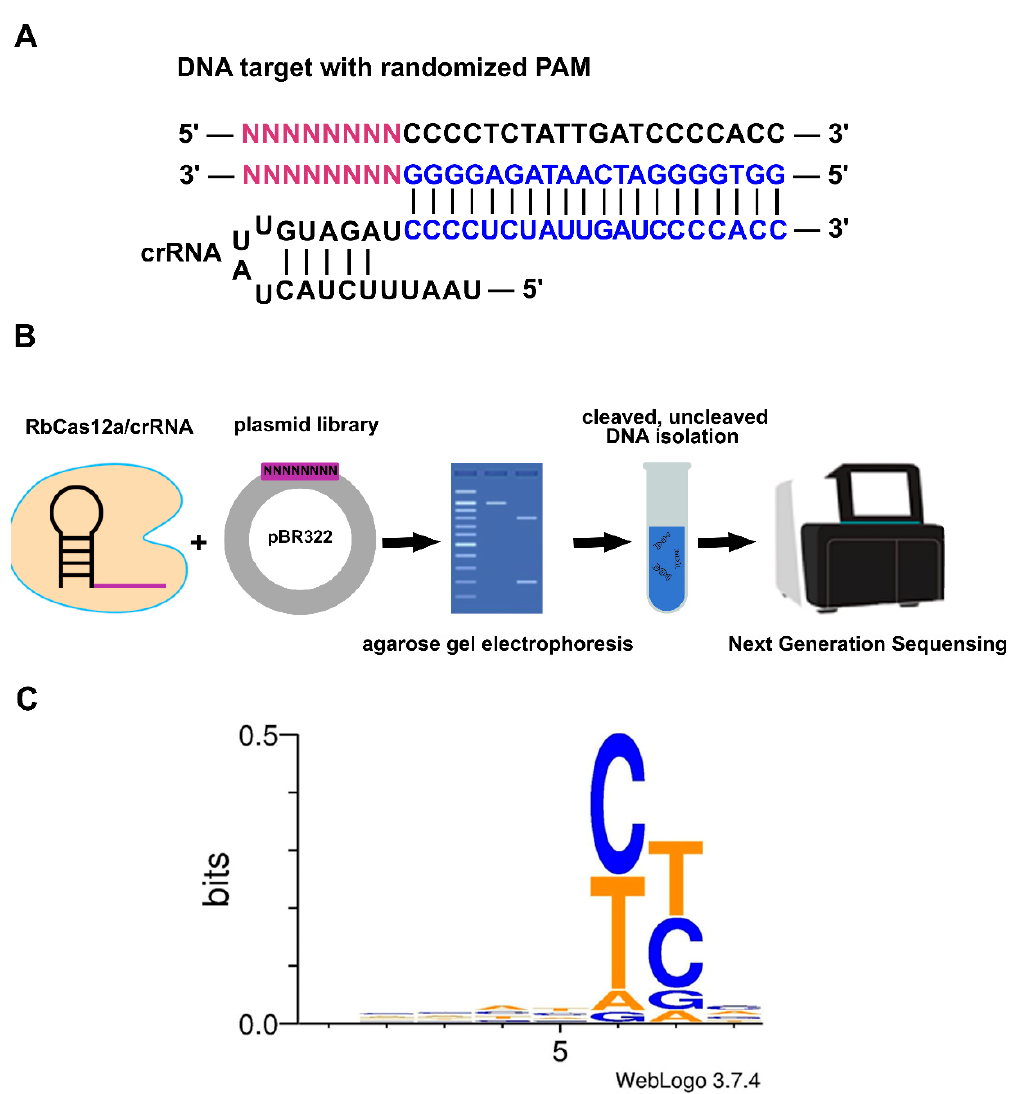
Figure 3. Ruminococcus bromii CRISPR–Cas Type V system PAM sequence logo determined by linear DNA PAM library sequencing. ( A ) Schematic of the RbCas12a crRNA–DNA-targeting complex. The target DNA contains eight random nucleotides at the 5 ′ -end PAM region. ( B ) Schematic illustration